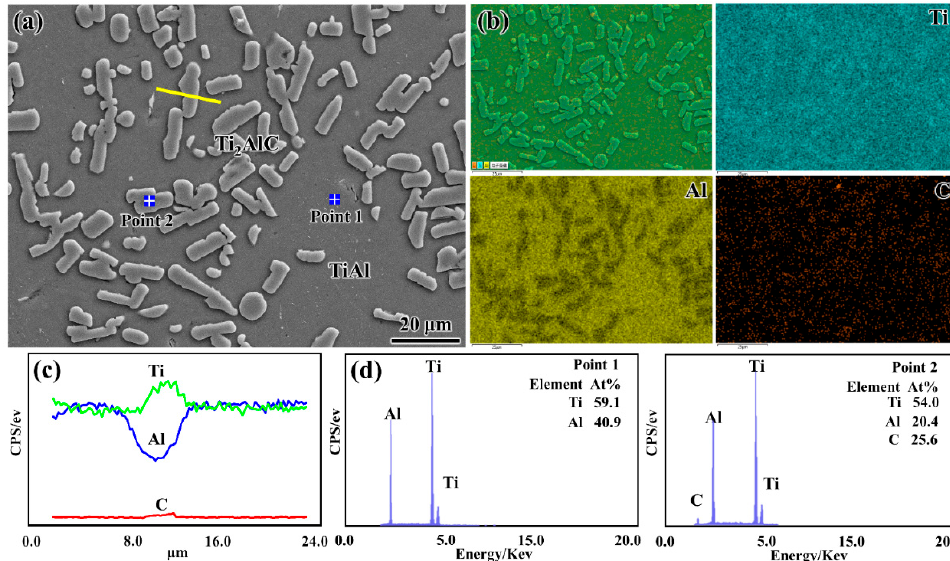
Figure 4. The SEM image and corresponding EDS analysis of the as-prepared Ti 2 AlC/TiAl composite: ( a ) SEM image; ( b ) element distribution maps in ( a ); ( c ) element distribution lines along the yellow line in ( a ); ( d ) point analysis of the regions marked in ( a ).